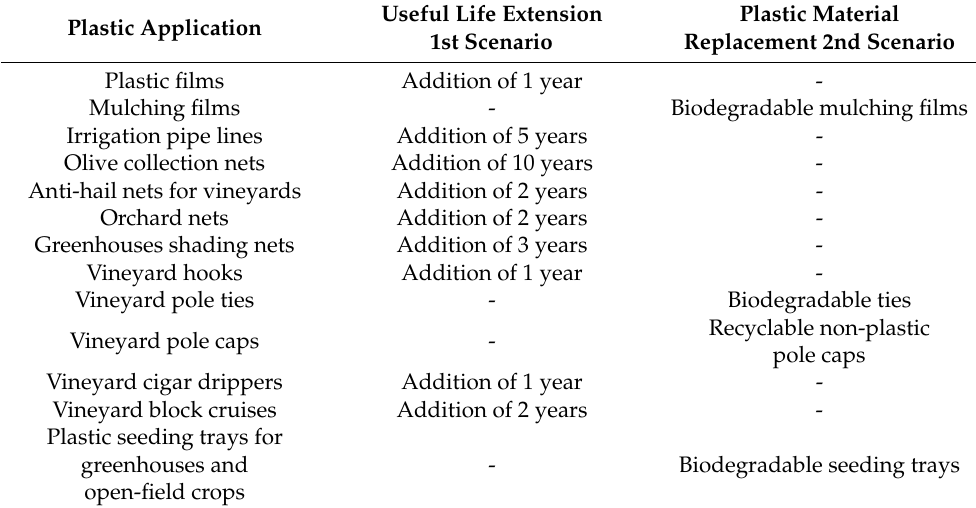
Table 1. Scenarios changes in respect to real-time scenario; 1st scenario based on the maximum useful life of the materials on the market; 2nd scenario based on the use of materials not generating plastic waste. Useful Life Extension Plastic Plastic Application 1st Scenario